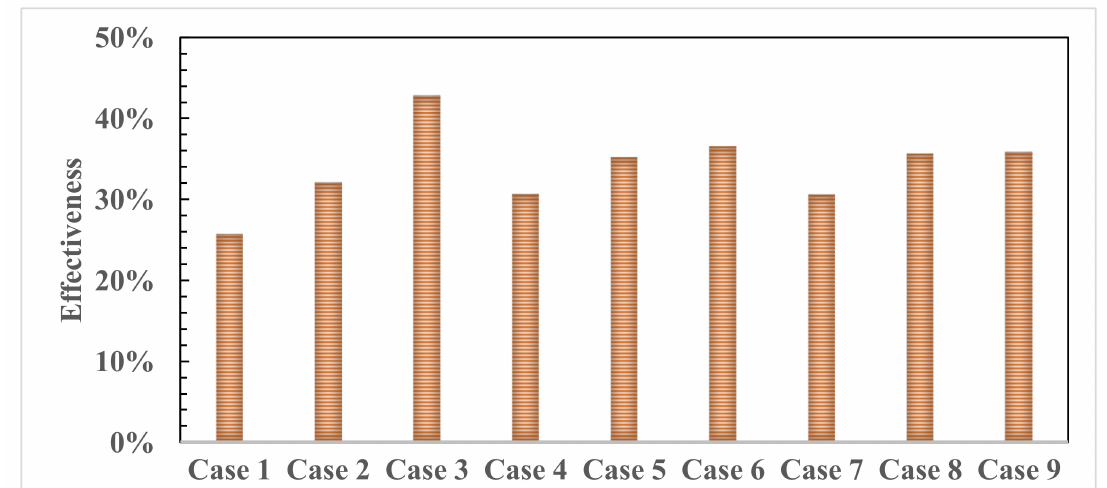
Figure 7. Compression effectiveness and temperature increase.